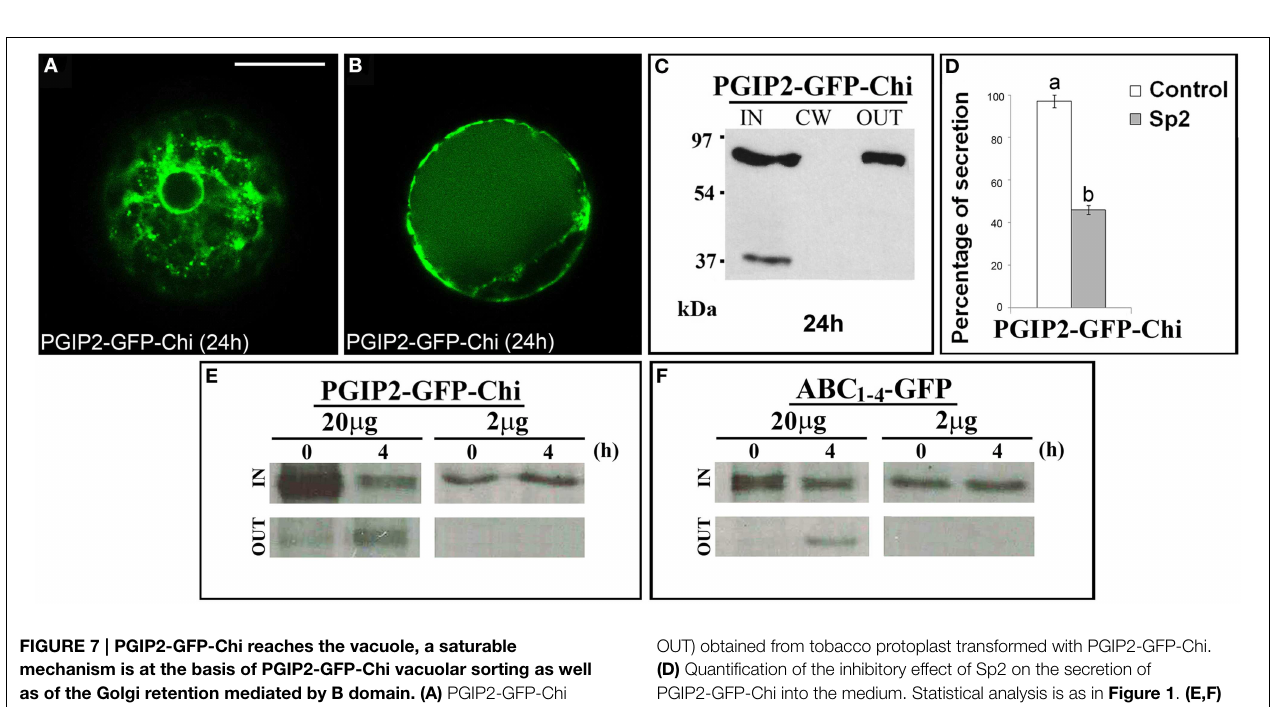
OUT) obtained from tobacco protoplast transformed with PGIP2-GFP-Chi. (D) Quantification of the inhibitory effect of Sp2 on the secretion of PGIP2-GFP-Chi into the medium. Statistical analysis is as in Figure 1 . (E,F) Intracellular and incubation medium protein fractions obtained from tobacco protoplasts transiently transformed with 20 or 2 µ g of the plasmid encoding PGIP2-GFP-Chi (E) or ABC1–4-GFP (F) , pulse-labeled for 1h with a protein labeling mixture [ 35 S] and chased for the indicated periods of time. Scale bars = 20 µ